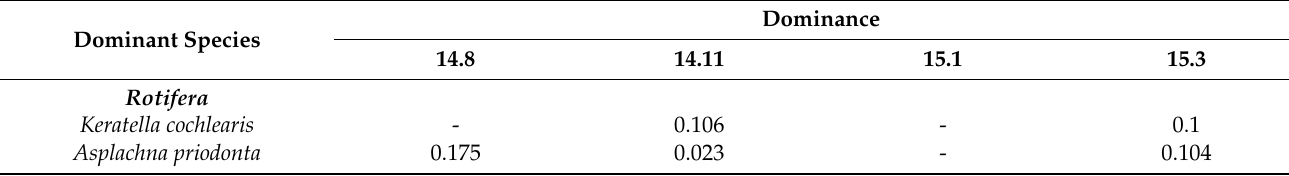
Table 3. Species and dominance of dominant zooplankton